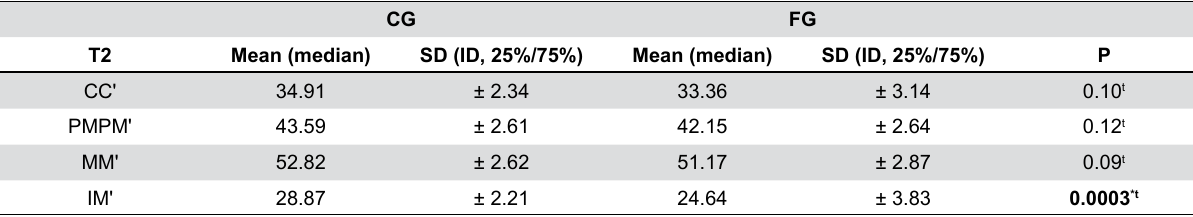
Table 2- Analysis of the linear dimension means (mm) in the studied groups after the end of orthodontic/rehabilitative treatment (T2)